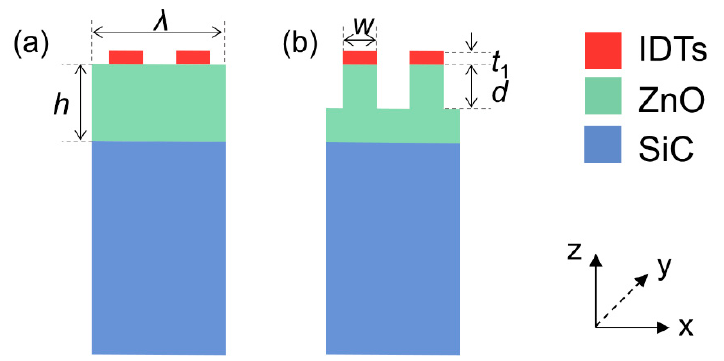
Figure 1. The structure schematic of ( a ) traditional multi-layer structure and ( b ) IDTs/partially etched ZnO/SiC structure.